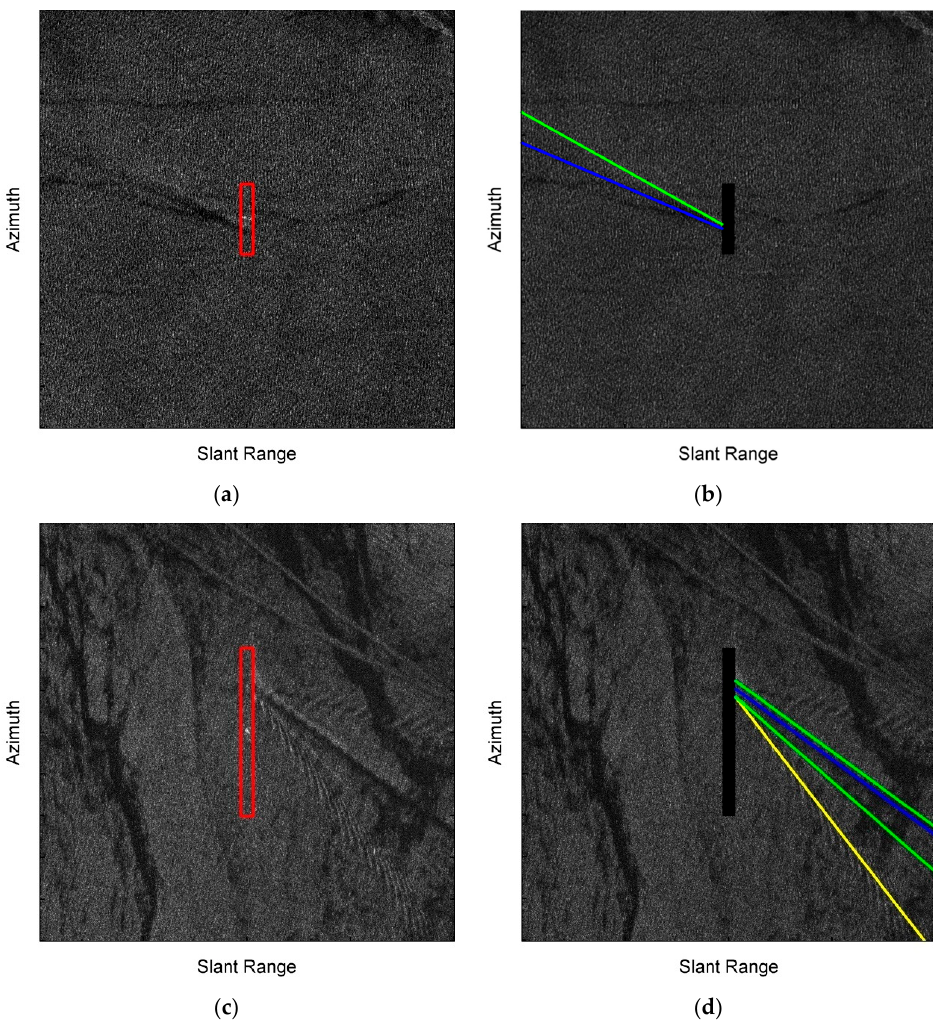
Figure 5. Wake detection examples: ( a ) masked image tile for Wake #33 in Table 4; ( b ) confirmed half lines for Wake #33 in Table 4; ( c ) masked image tile for Wake #1 in Table 3; ( d ) confirmed half lines for Wake #1 in Table 3. Remote Sens. 2016 , 8 , 498